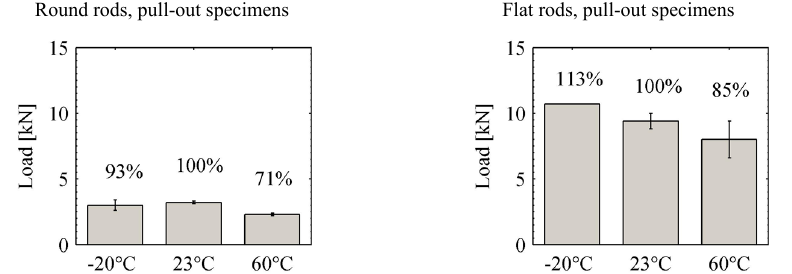
Figure 5: Bar graph of the mean pull-out strength values relative to the reference temperature